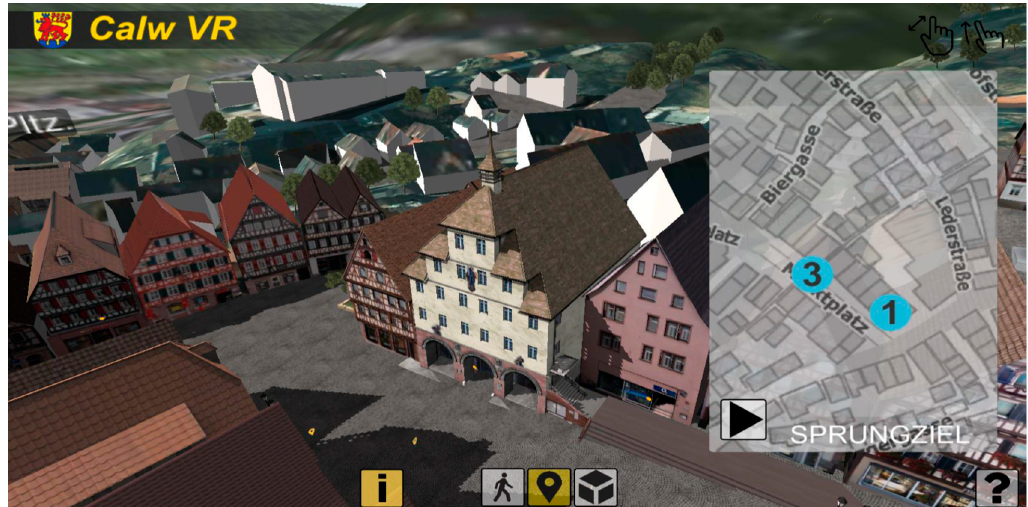
Figure 5. Screen (above) and closer view to the town hall (below) of the App Calw VR.